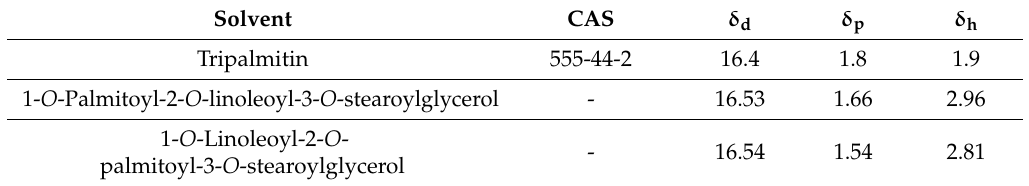
Table 4. Estimated value of Hansen solubility parameter of each triacylglycerol.